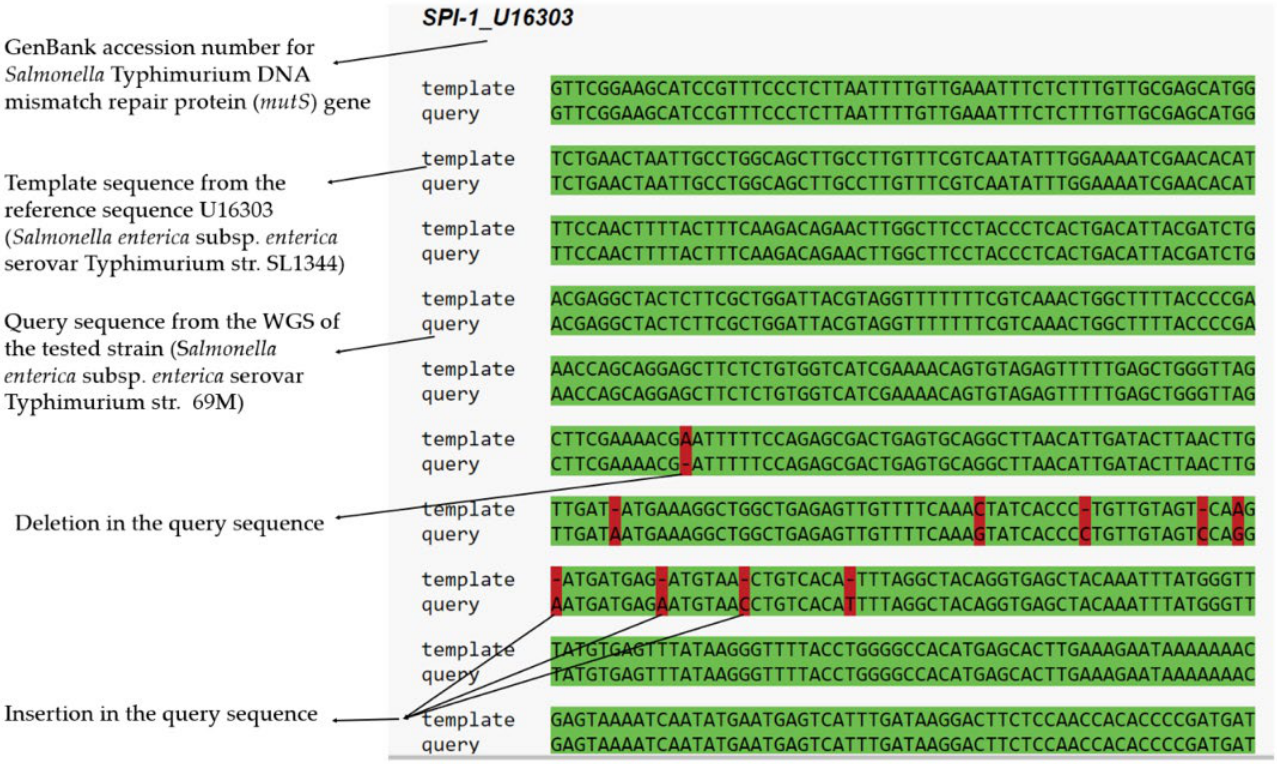
Figure 3. Fragment of SPI 1 with the mutS gene. Analysis performed by SPIFinder 2.0. alignment of the mutS gene; query ( Salmonella Typhimurium 69M from human milk) and template (U16303 – Salmonella enterica subsp. enterica serovar Typhimurium str. SL1344). The query sequence was found to demonstrate the greatest similarity (99.43%) with the Salmonella Typhimurium DNA mismatch repair protein ( mutS ) gene sequence (U16303).